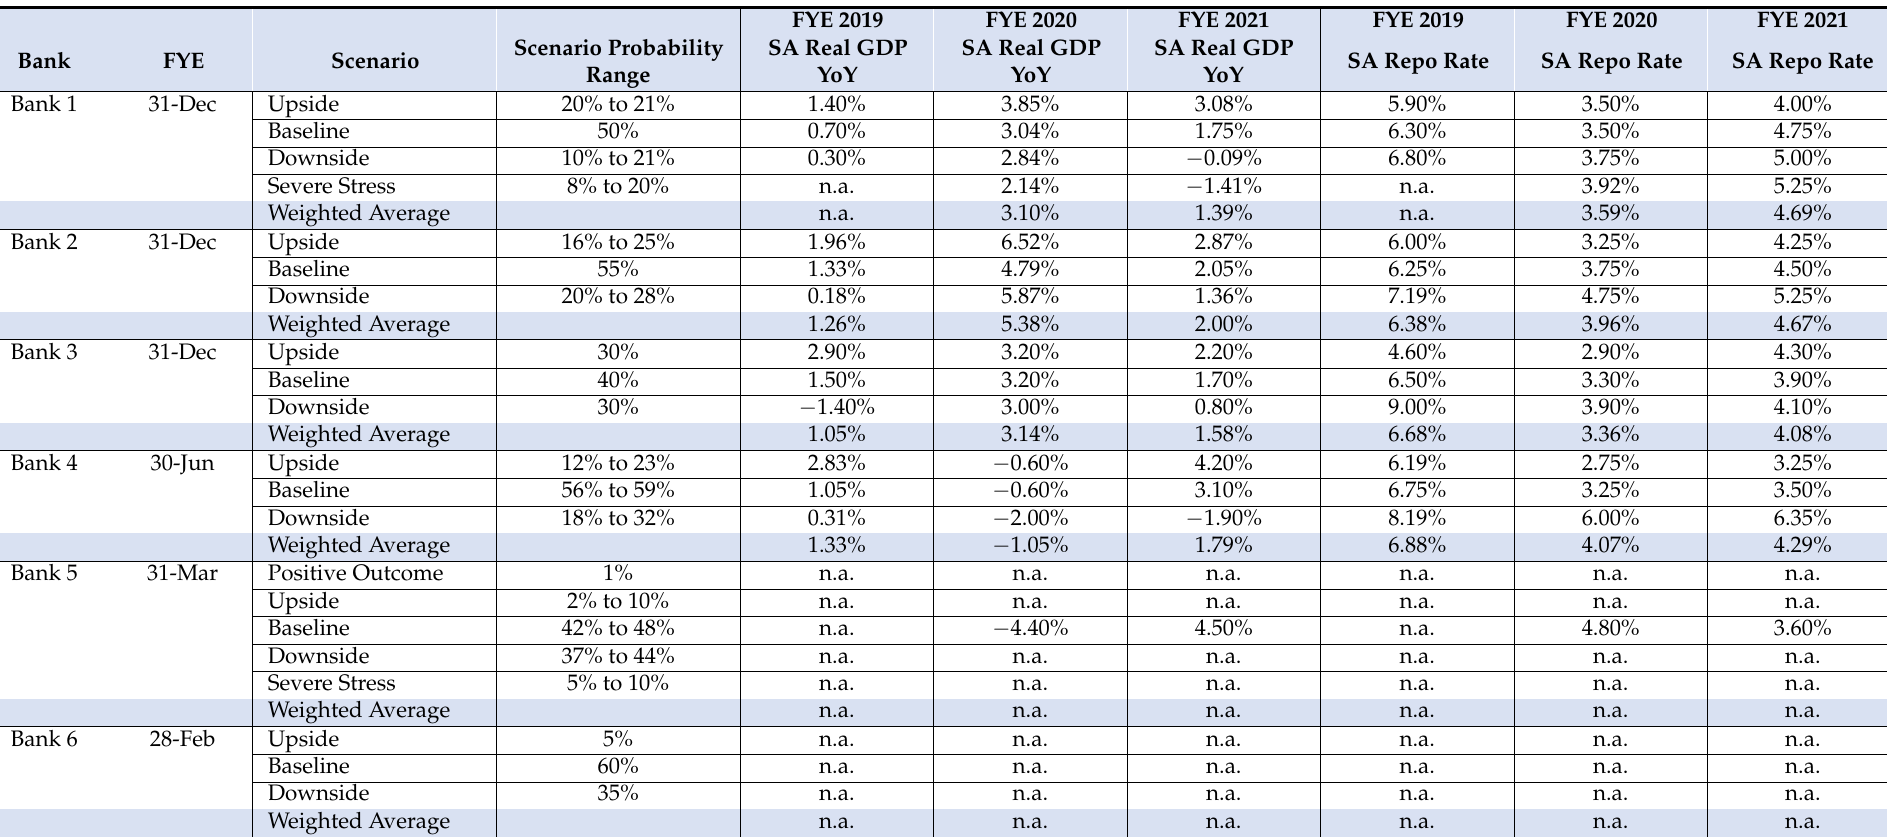
Table 1. Economic outlook over a 1-year period for select economic variables as disclosed by six South African banks in their annual financial